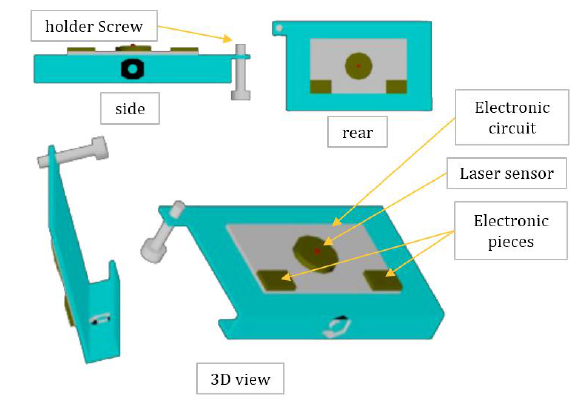
Figure 3. Conceptual diagram of Ubi-Total Station stand 2.2.3